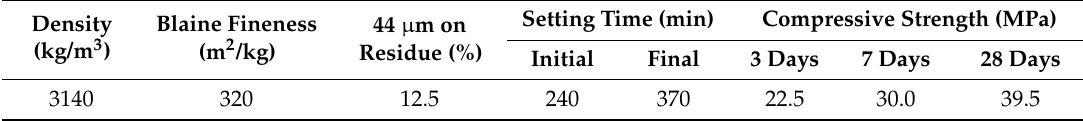
Table 4. Properties of cement.